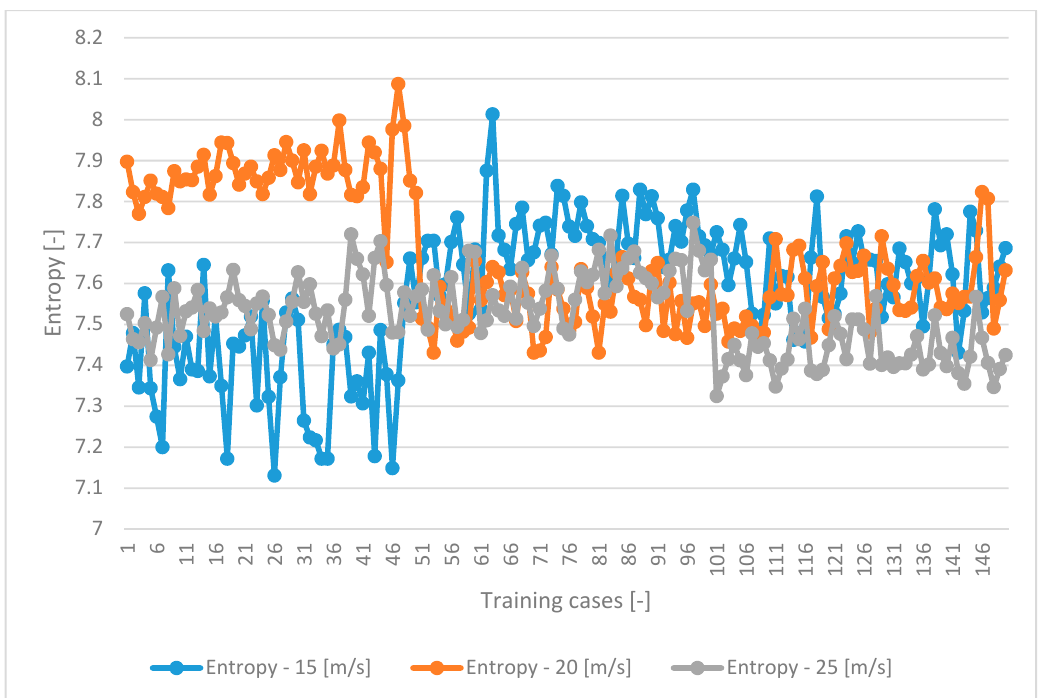
Figure 4. The distribution values of the entropy variable in the dataset depending on the sowing speed.